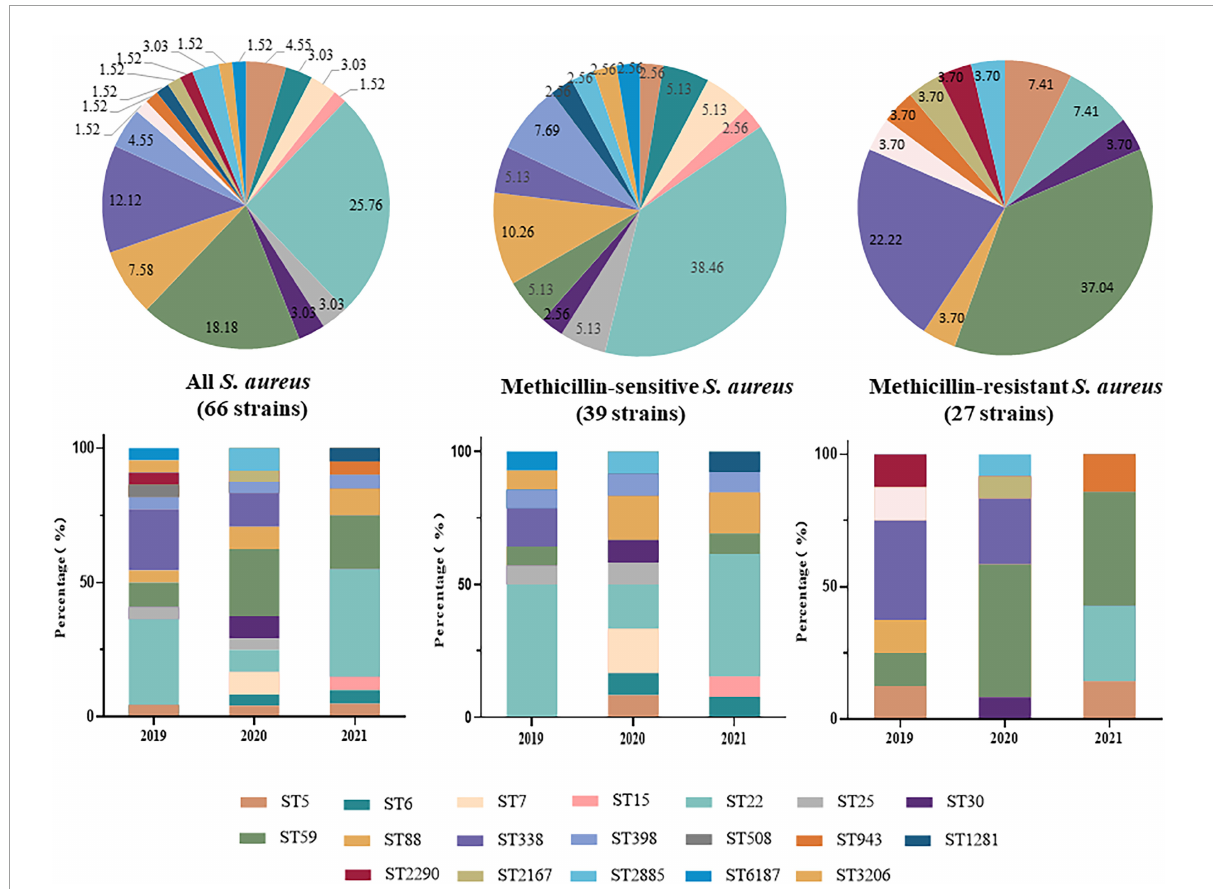
FIGURE1 Distribution and changes in Sequence Types (STs) of 66 invasive Staphylococcus aureus strains from 2019 to 2021.